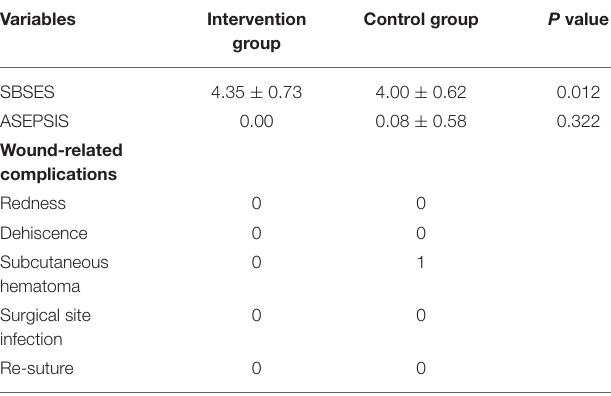
TABLE 4 | Comparisons of wound score and wound-related complications between two groups.